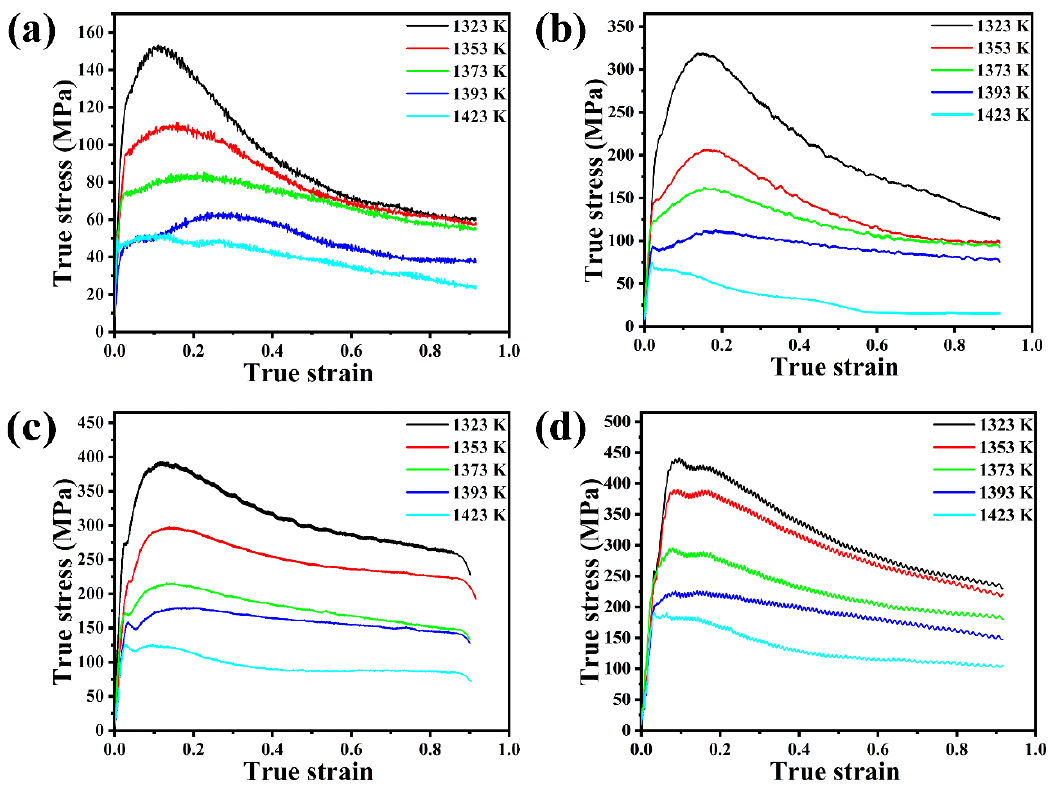
Figure 2. True stress–true strain curves of studied superalloy at different deformation conditions: ( a ) 0.01 s −1 , ( b ) 0.1 s −1 , ( c ) 1 s −1 , ( d ) 5 s −1 .